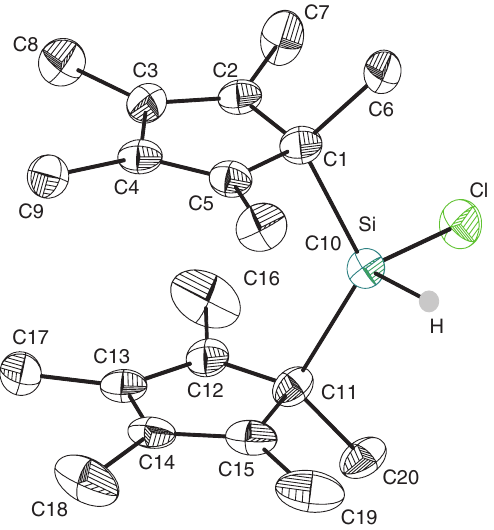
Figure 3: ORTEP at 20% probability and atom numbering scheme for compound D